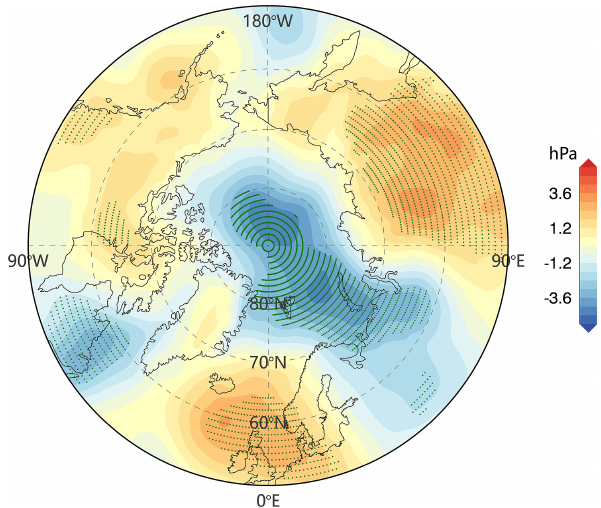
Figure 2. Spatial patterns of SLP anomalies during April to June 2020. The anomalies are computed as the difference between the averaged fields of the 3 months (April to June) and the corre- sponding climatology over the past four decades (1979–2020). Stip- plings represent the values where the anomaly exceeds 1 standard